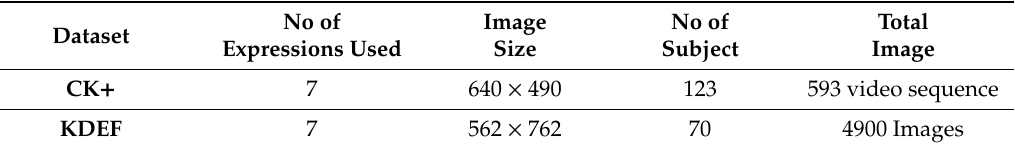
Table 2. Used datasets in the proposed method.